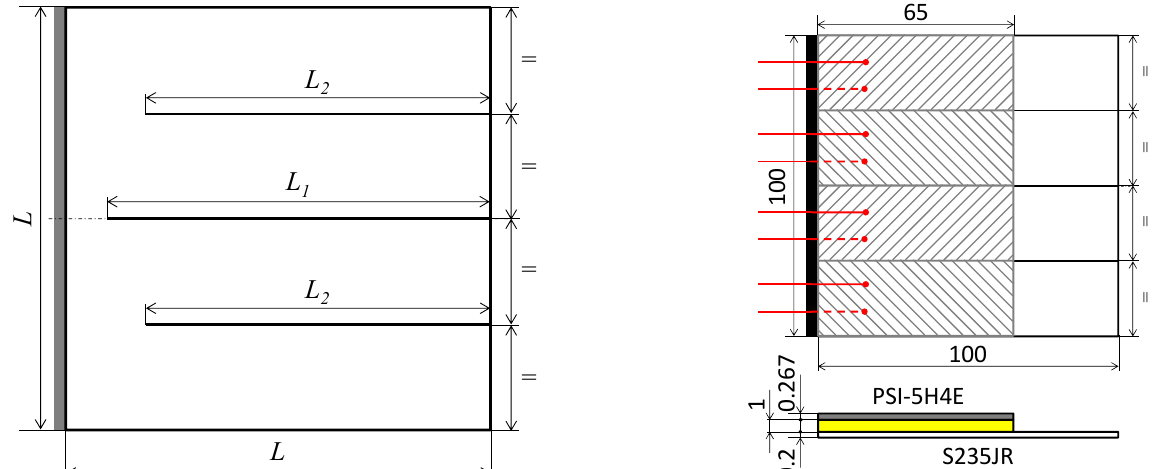
Figure 2: Sketch of the prototype of the piezoelectric converter